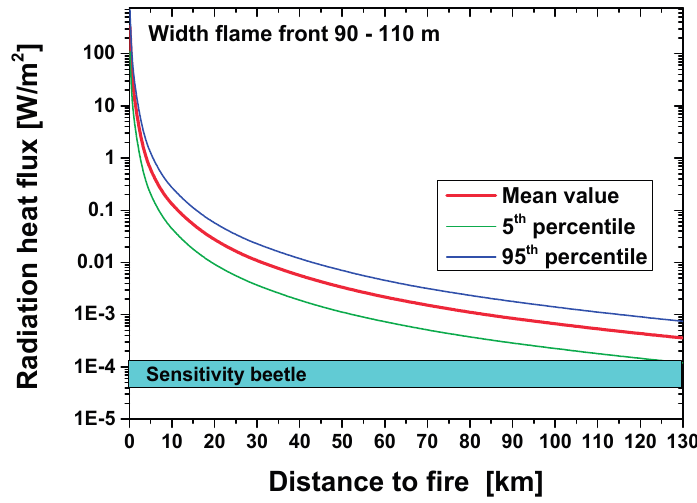
Figure 4. Radiation heat flux (flame front 90–110 m) as function of the fire distance.